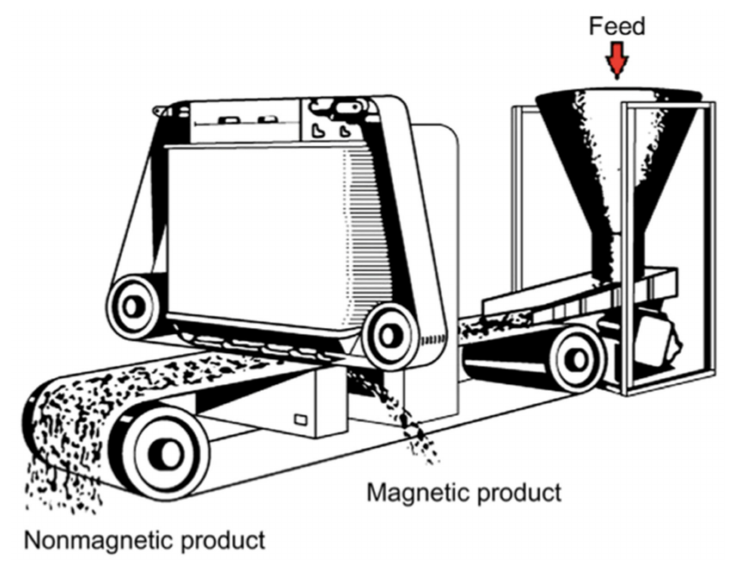
Figure 7. Cross belt